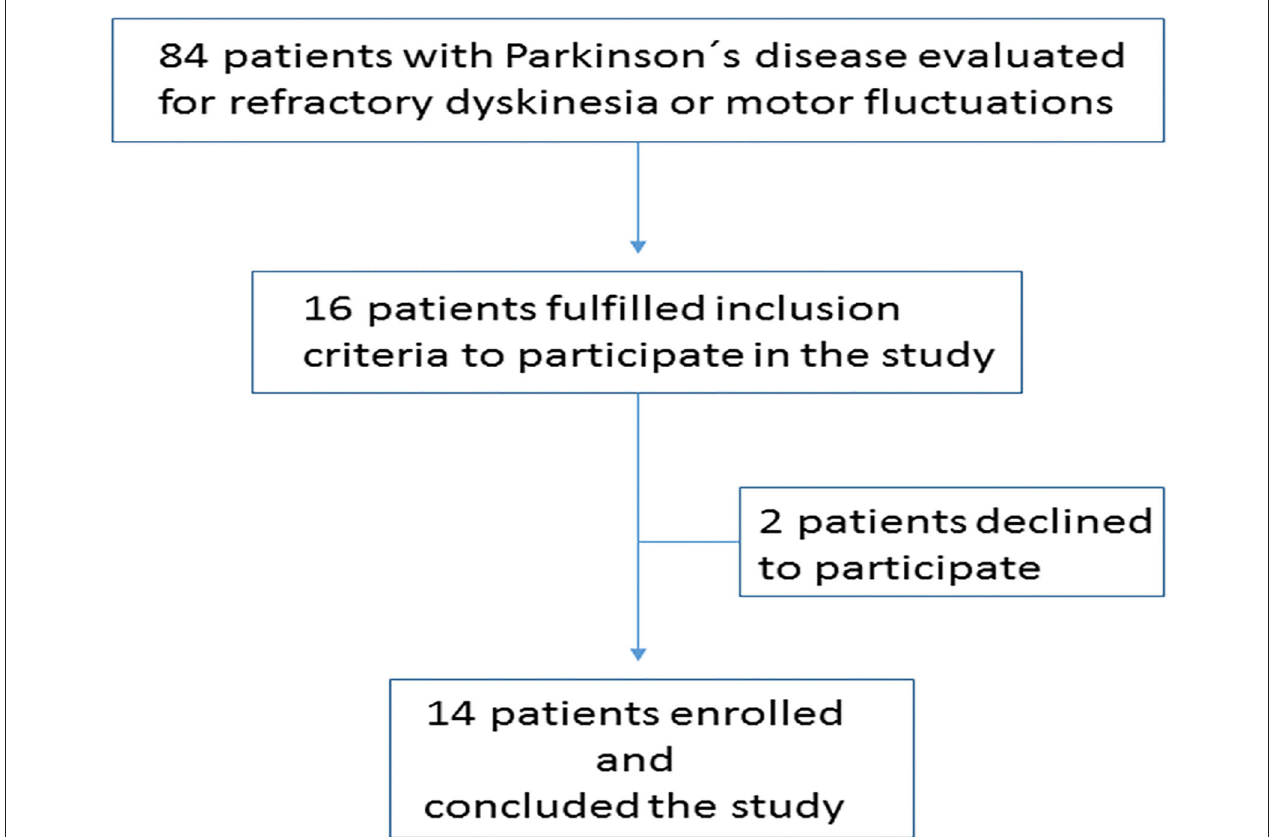
FIGURE 1 | Cohort